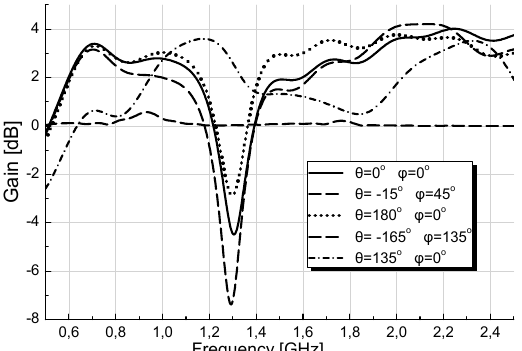
Figure 11. Antenna’s Realized Gain versus frequency toward the directions of arrival (DoAs) of the previous results.